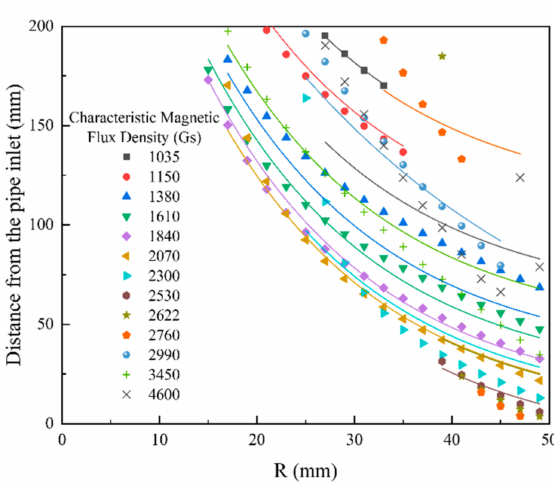
Figure 8. Distance from the pipe inlet of deposited ions with emission